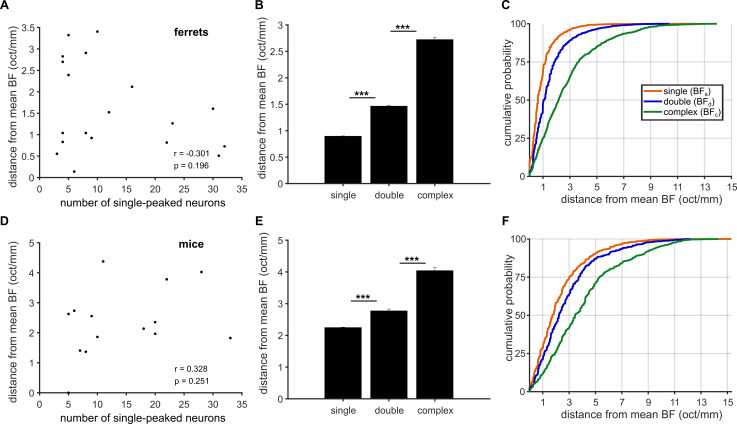
The BF variance within an imaging field does not depend on the number of neurons in the field.(A) BF variance for single-peaked neurons in ferrets is plotted as a function of the number of these neurons within an imaging field, for all imaging fields containing at least three single-peaked, three double-peaked, and three complex neurons. The statistics of a Pearson’s correlation of these two values are given in the bottom right of the plot. (B) For each ferret imaging field, we estimated the BF variance for each neuron class using only three neurons, and this calculation was repeated for every possible combination of 3 neurons. The bar plot shows the average (mean ± SEM) BF variance across all iterations for each neuron type (t-test; *** p < 0.001). (C) Cumulative probability of the bootstrapped BF variance within ferret imaging fields, for single-peaked (orange), double-peaked (blue) and complex (green) neurons. (D - F) Results plotted as in A, B, C above (respectively), but for mouse data.